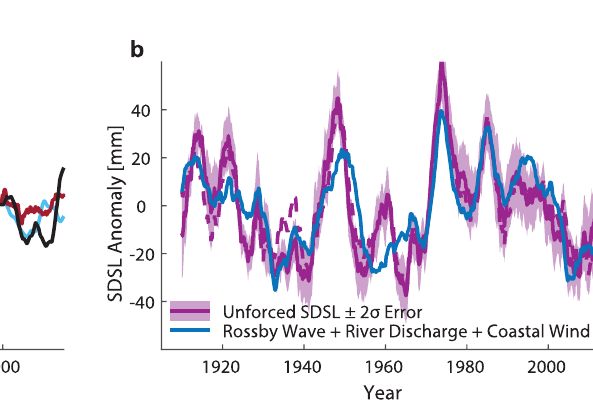
have been smoothed with a moving average fi lter of 48 months. b Lead-lag corre- lation analysis; the left side indicates correlations when the Caribbean Sea leads, while the right side indicates lagged correlations.